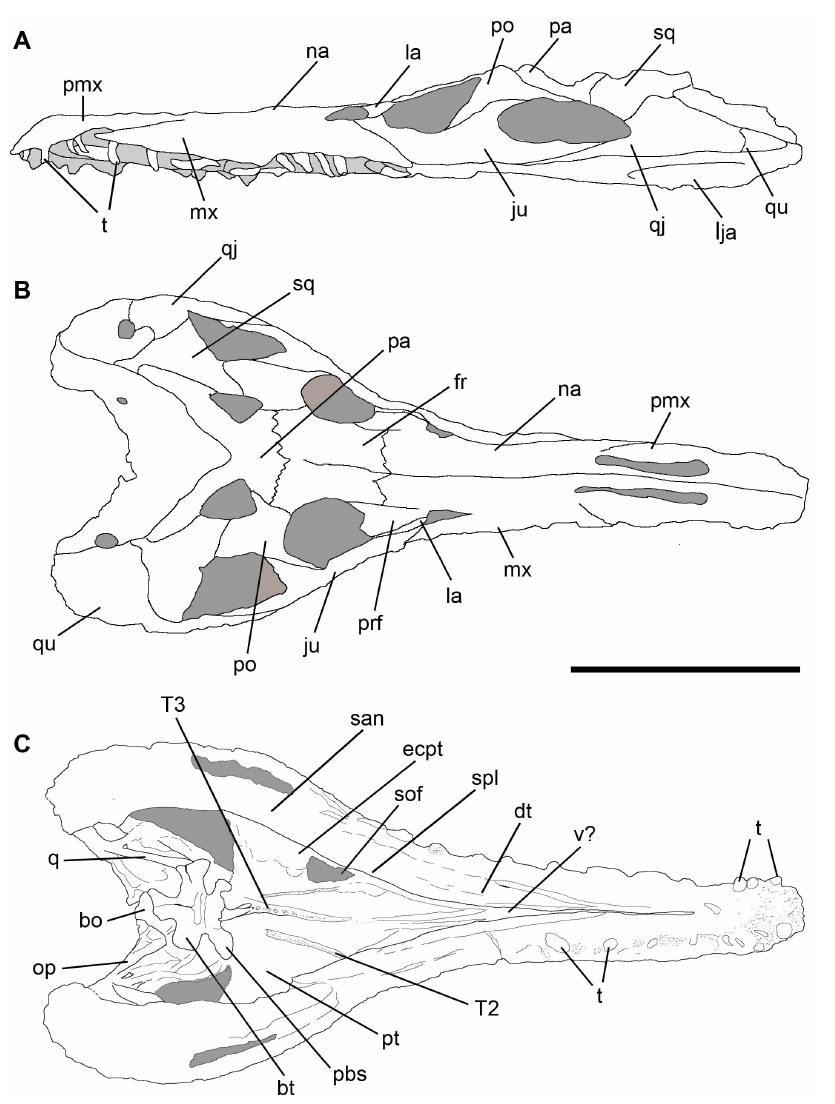
Figure 4. Line drawings showing sutures in the skull of Pseudochampsa ischigualastensis (PVSJ 567) in (A) left lateral, (B) dorsal, and (C) ventral views. Abbreviations: bo, basioccipital; bt, basal tubera; dt, dentary; ecpt, ectopterygoid; fr, frontal; ju, jugal; la, lacrimal; lja, lower jaw; mx, maxilla; na, nasal; op, opisthotic; pa, parietal; pbs, parabasisphenoid; pmx, premaxilla; po, postorbital; prf, prefrontal; pt, pterygoid; qj, quadratojugal; q, quadrate; san, surangular; sof, suborbital fenestra; sq, squamosal; spl, splenial; t, teeth; T2, palate tooth row 2; T3, palate tooth row 3; v?, vomer?. Scale bar equals 5